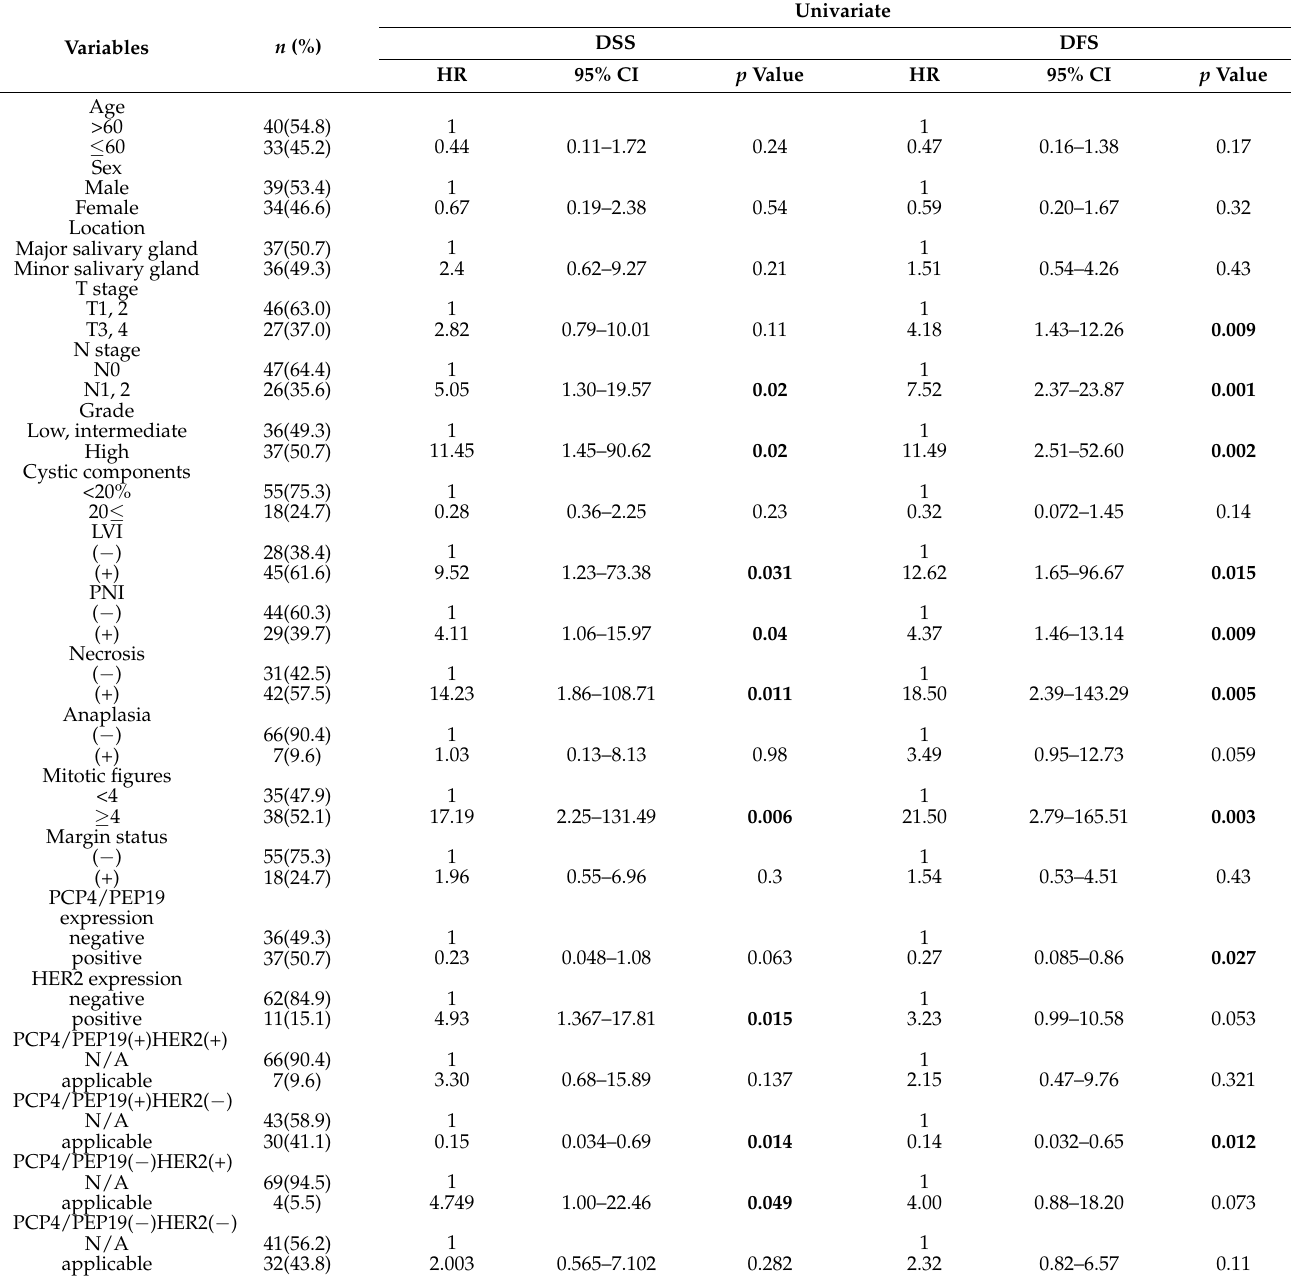
Table 3. Univariate Cox proportional hazards analysis of clinicopathological variates and predictors of DSS and